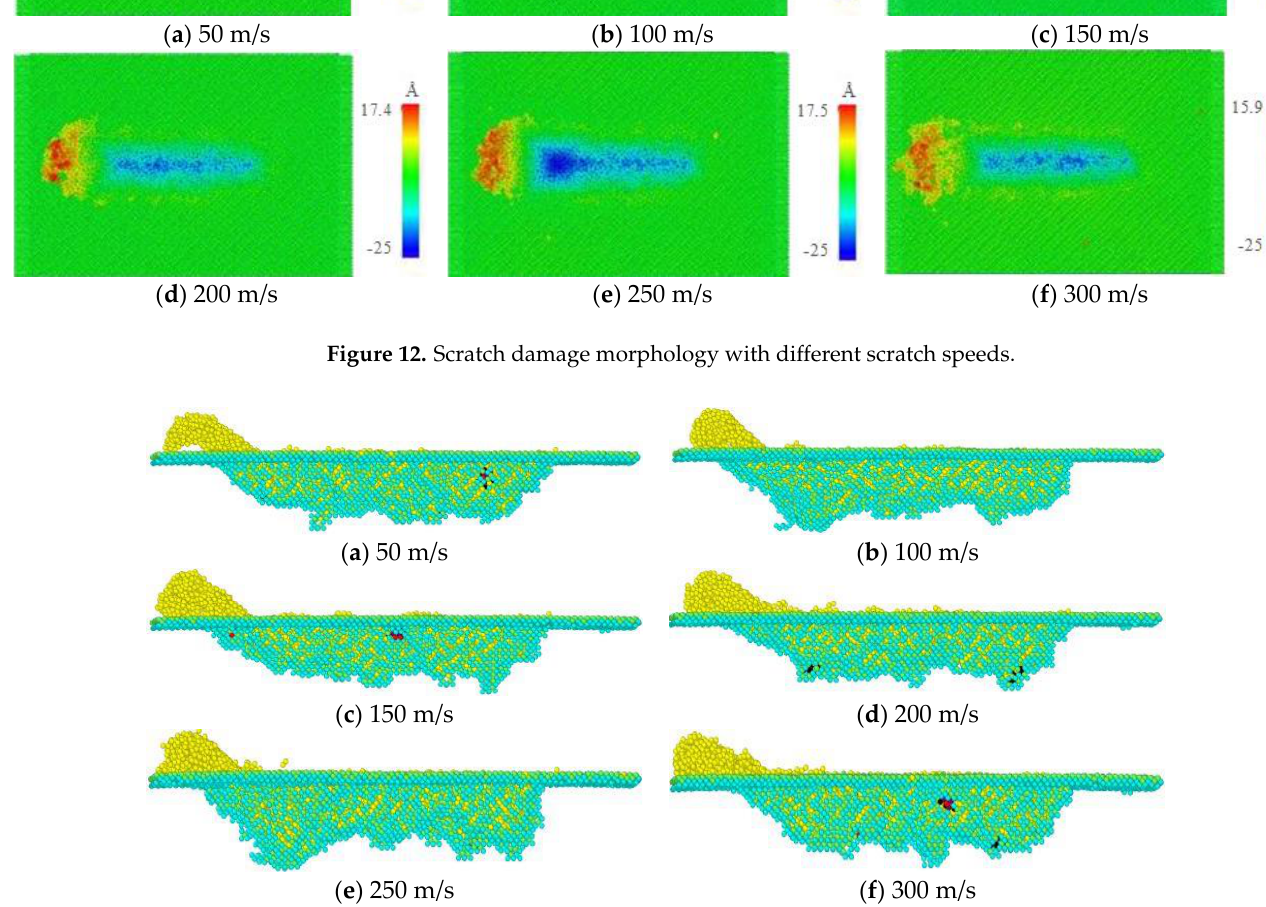
Figure 13. Internal structure with different scratch speeds.